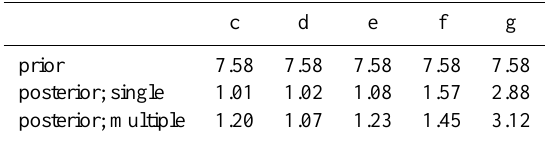
Table 1. The maximum variance in prior and posterior models for the di ff erent beam coverage scenarios depicted in Figs. 3c–g and